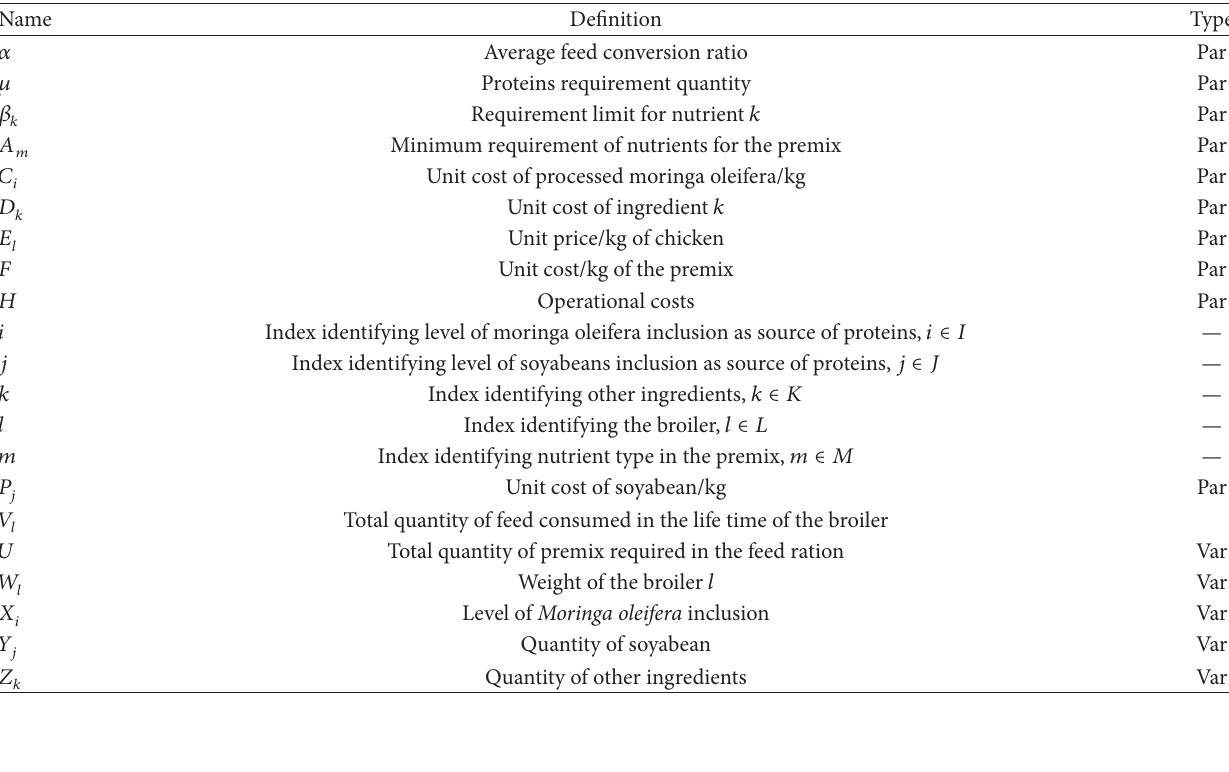
Table 1: Definitions of parameters and